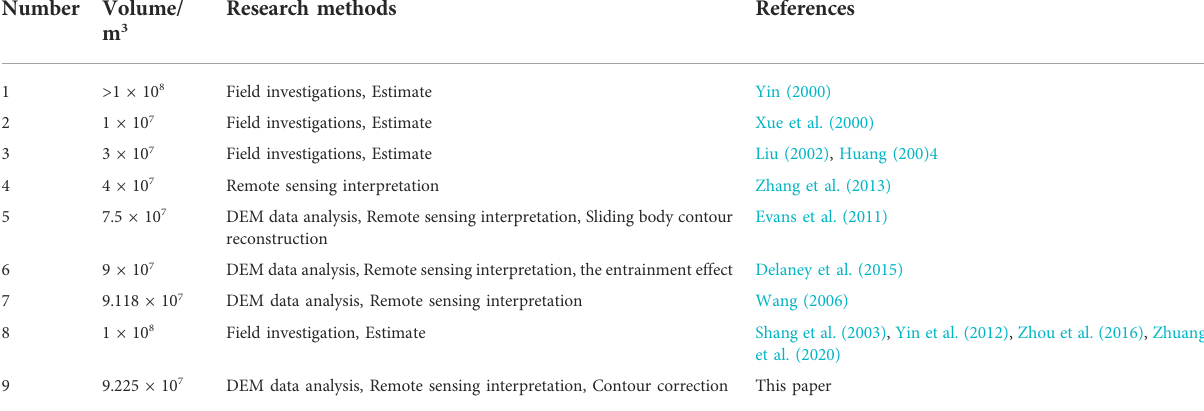
TABLE 2 Historical studies summary of the initial landslide volume of the Yigong landslide in 2000.